Question: Compose a caption that would accompany this figure in a paper.
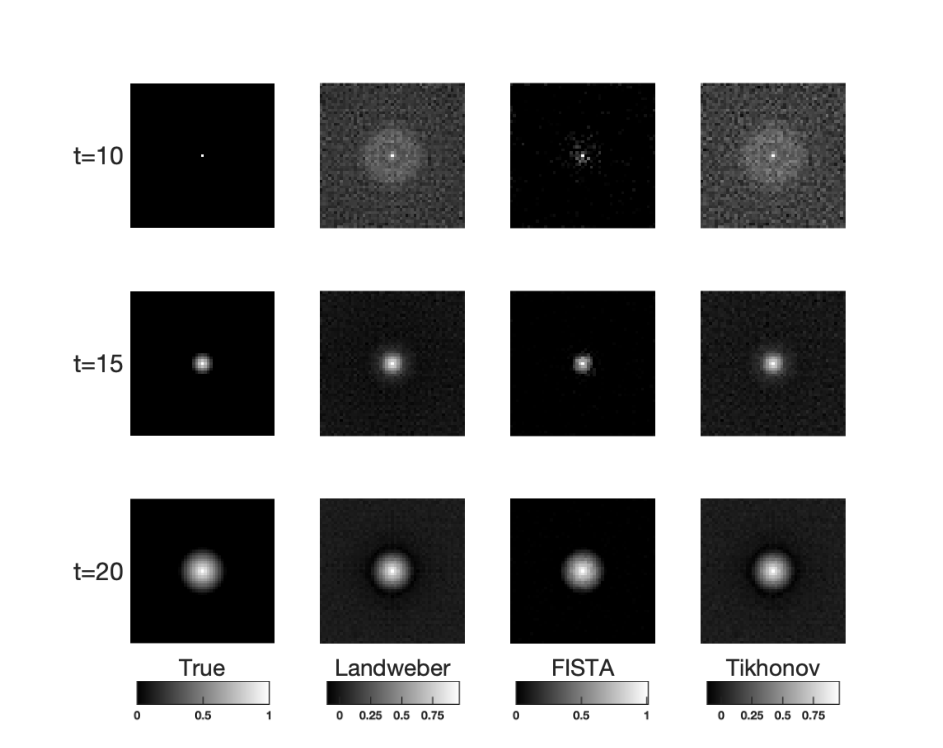
Answer: Selected slices of the lowest RRE string reconstructions for Example #2 with 5% noise and a = 1.